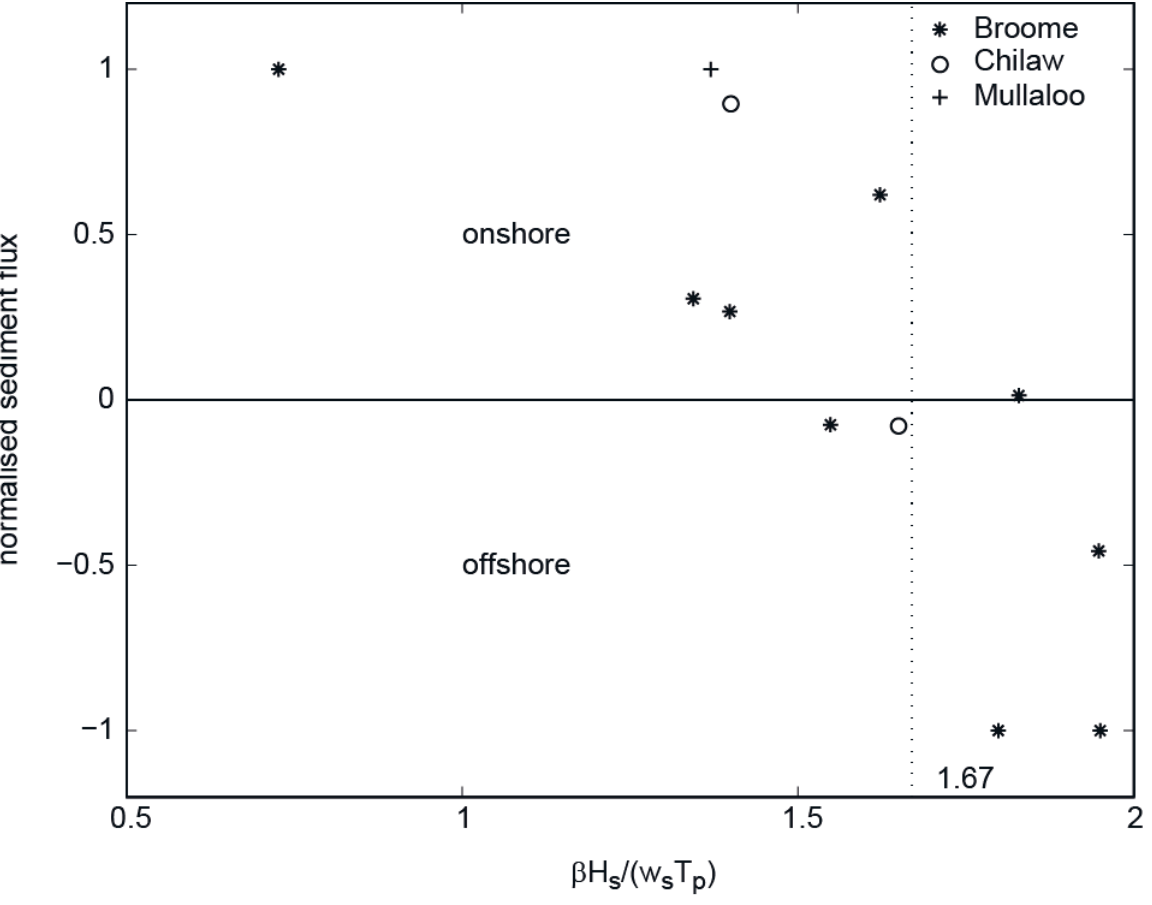
Figure 12. Variation of normalised net cross-shore suspended sediment flux with the Dean number ( β H /(w .T s s p